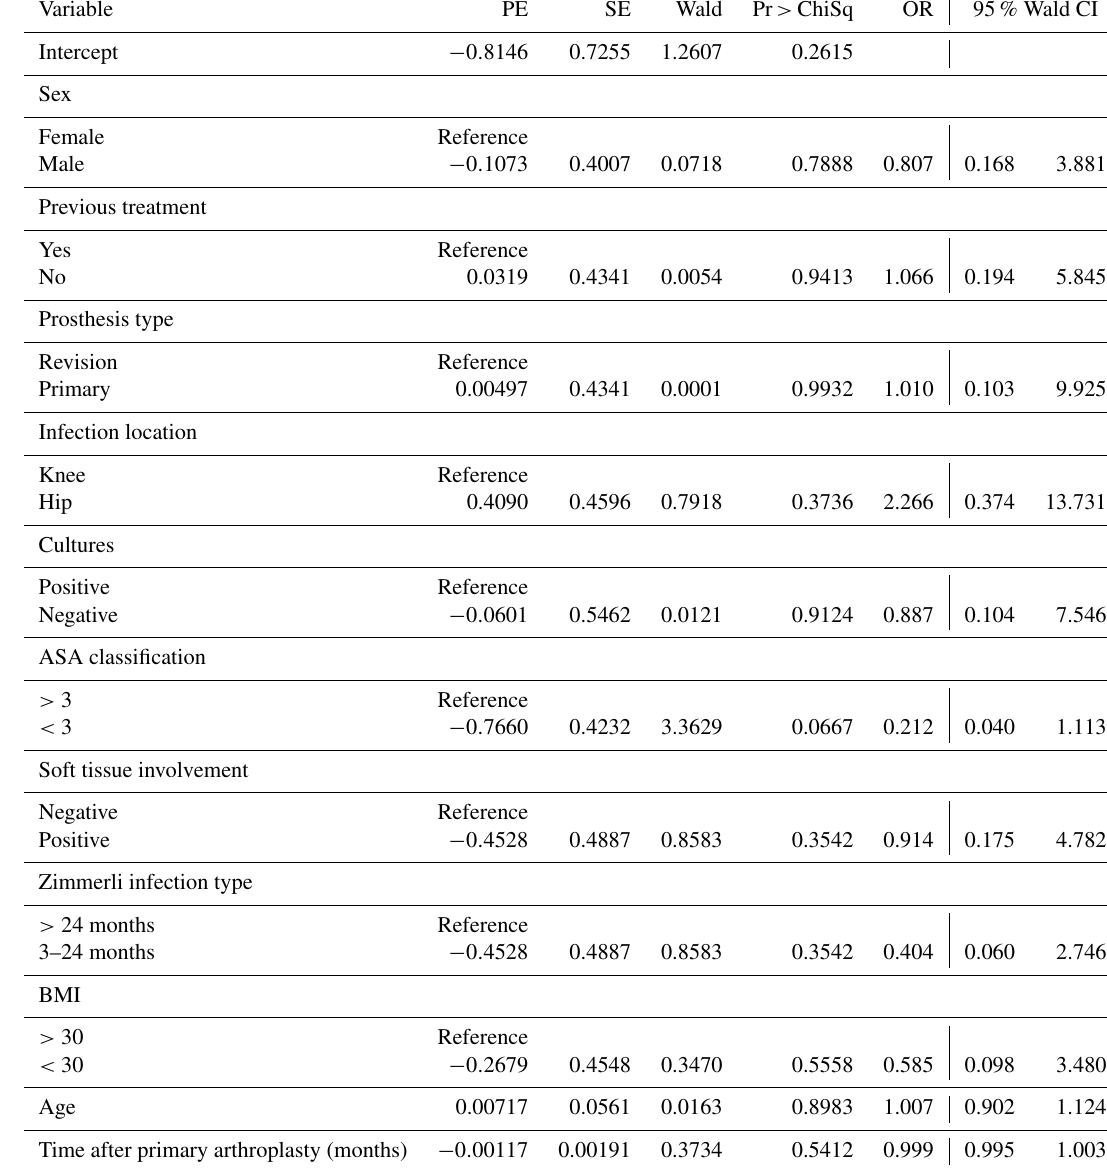
Table 3. Firth’s logistic